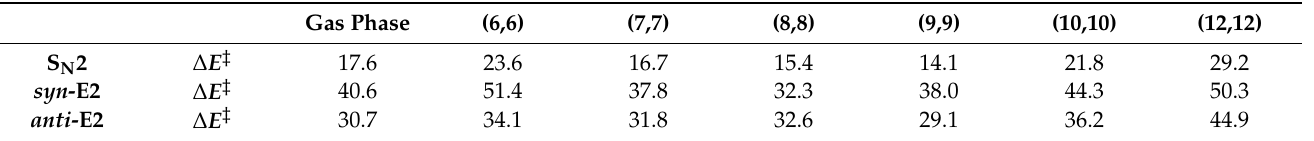
Table 3. Reaction energies (kcal mol −1 ) of the S Table 2. Activation energies (kcal mol − 1 ) of the S N 2, and syn - and anti -E2 reaction mechanisms inside CNT cavities. CNT cavities.